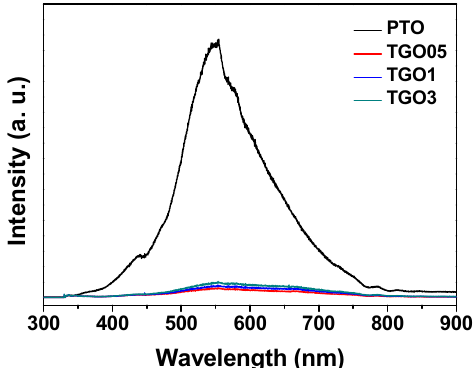
Figure 3. Photoluminescence spectra of pristine SnO 2 aerogel (PTO) and SnO 2 aerogel/reduced graphene oxide (rGO) nanocomposites with different rGO loadings (0.05 wt.%: TGO05; 0.1 wt.%: TGO1; 0.3 wt.%: TGO3).